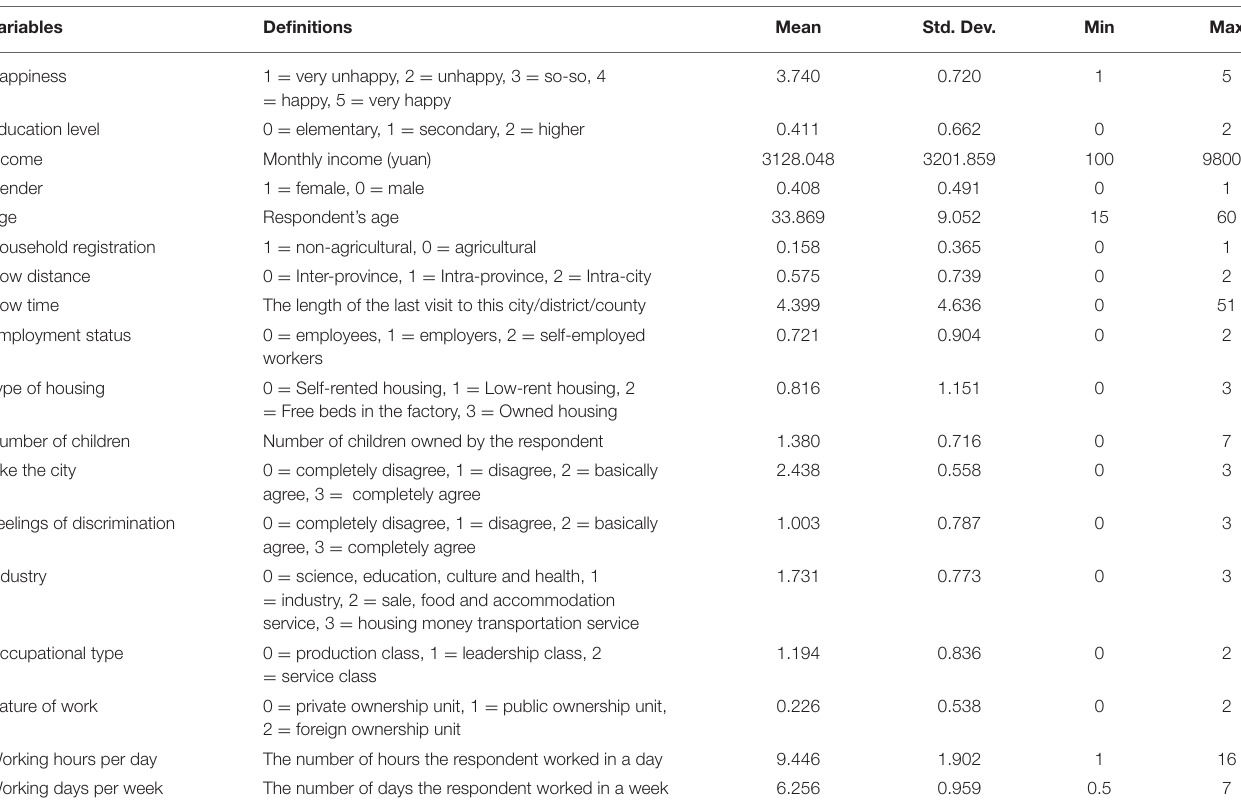
TABLE 1 | Descriptive